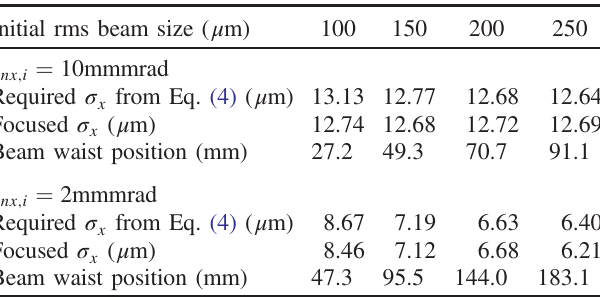
TABLE IV. RMS beam size at the focal point and beam waist position after the APL with different initial beam sizes. The required σ was calculated using Eq. (4) with the final normalized x emittance listed in Table III.